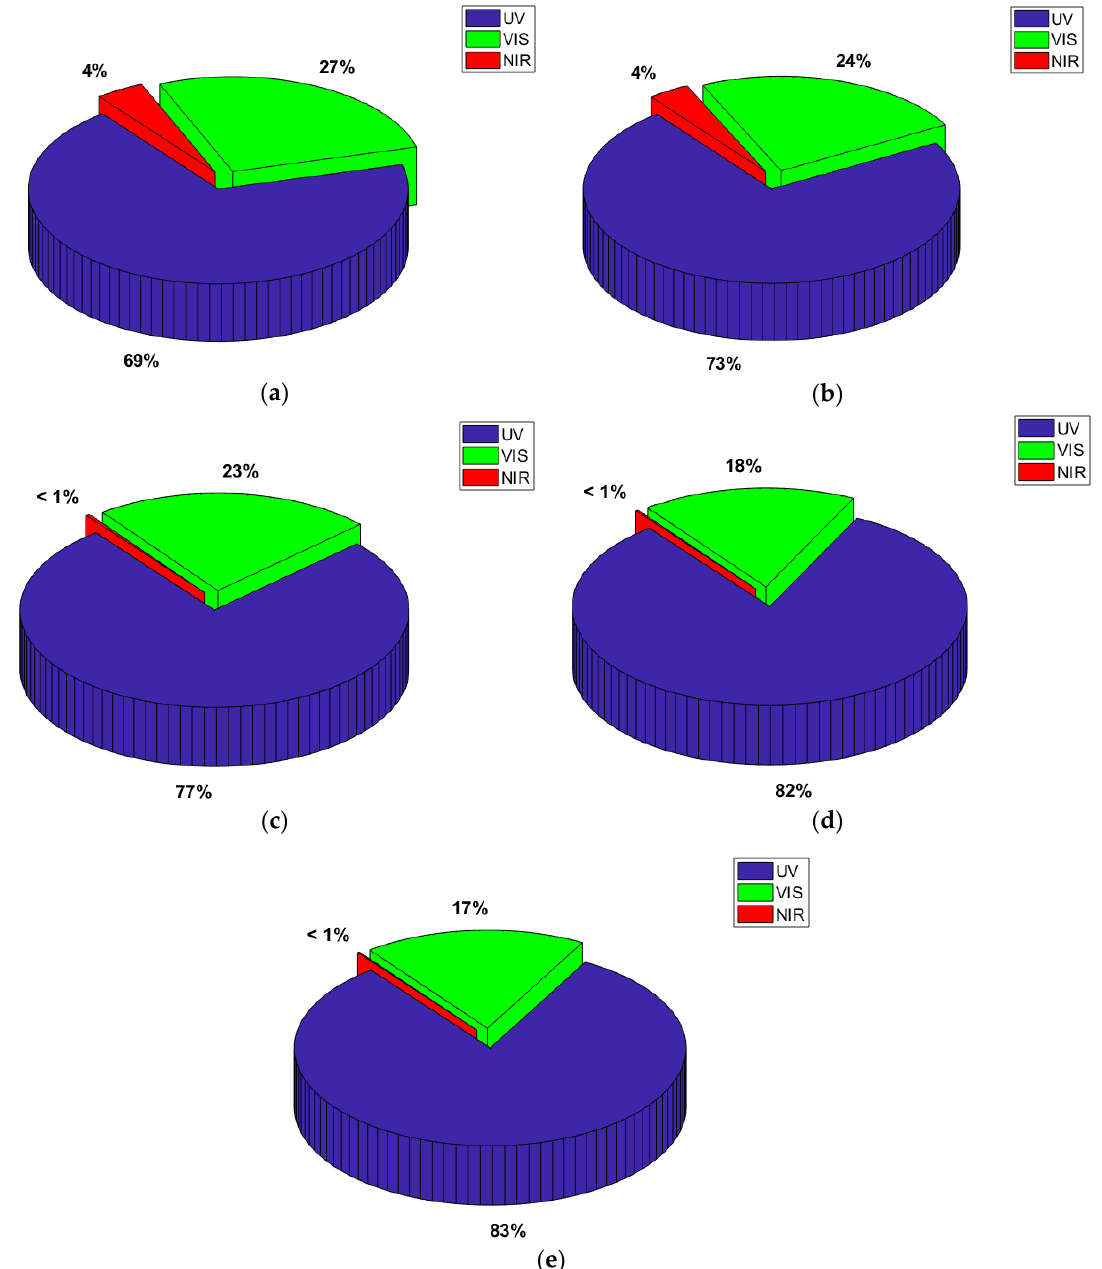
Figure 4. Percentage of the optical energy of the individual spectral bands for the arc generation voltage frequency f = 13.5 kHz (a); f = 20.0 kHz (b); f = 80.0 kHz (c); f = 100.0 kHz (d); f = 150.0 kHz (e).